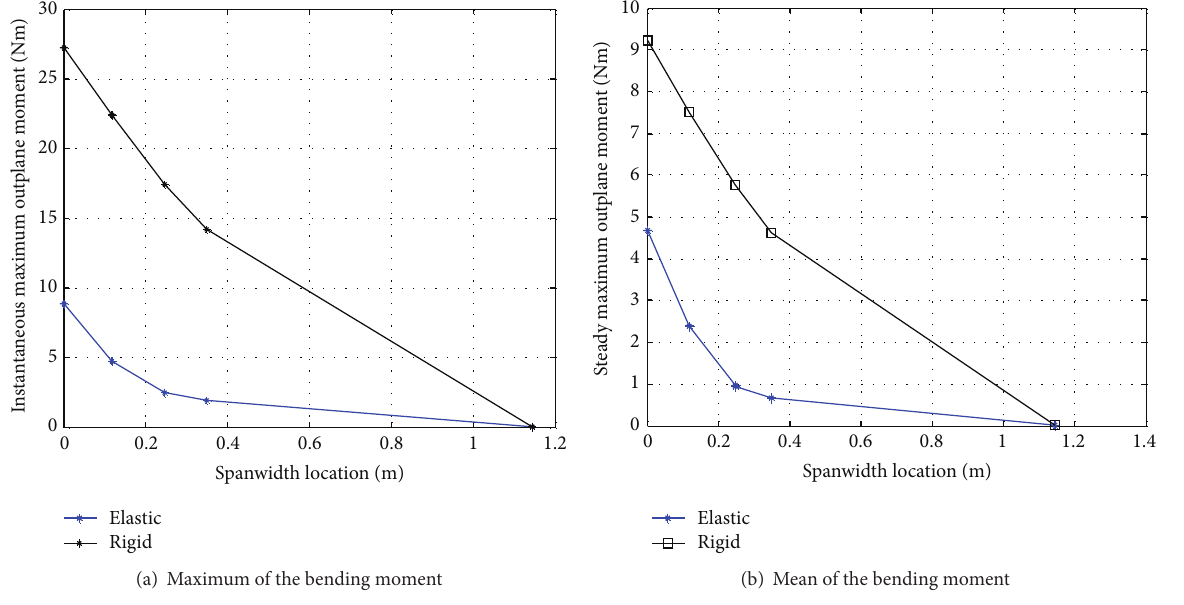
Figure 13: Comparison of bending moment between elastic blade and rigid